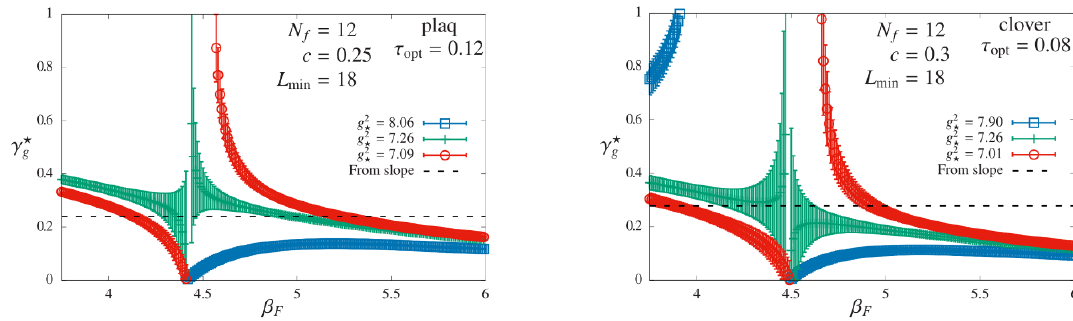
Figure 7 . Finite-size scaling results for (cid:13) ? using rational-function interpolations of the data in g (cid:12)gure 6, for the same plaquette discretization of E ( t ) at c = 0 : 25 (left, with (cid:28) (plaq) = 0 : 12) and opt clover discretization at c = 0 : 3 (right, with (cid:28) opt = 0 : 08). As expected, the signal vanishes around (cid:12) F (cid:25) 4 : 5 where g 2 is close to g 2 for all L , but the results are clearly consistent with the more precise e c ? predictions for (cid:13) ? from the slopes of the discrete (cid:12) functions in (cid:12)gure 4 (dashed lines). In each plot g the three curves correspond to the central value of g 2 = 7 : 26 (green crosses) plus the minimum and ? maximum values of g 2 consistent with the combined statistical and systematic errors (red circles ? and blue squares,